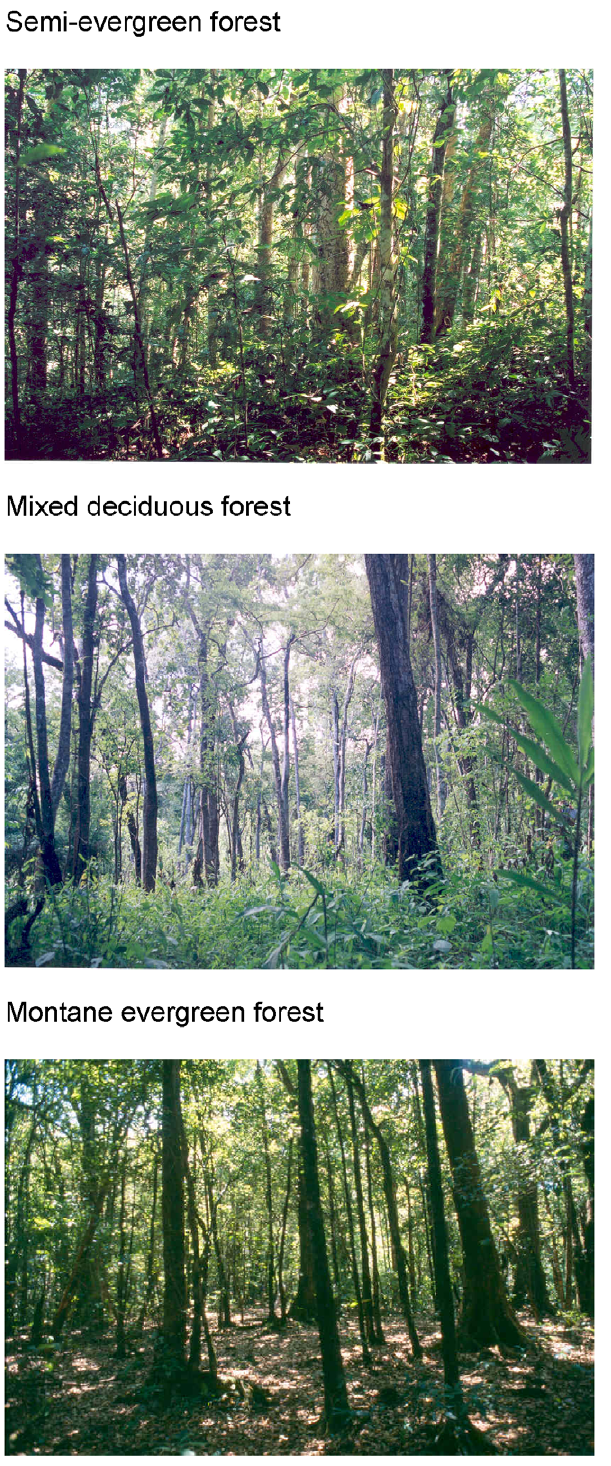
Figure 2. Forest types used by Asiatic black bears and sun bears in Thung Yai Naresuan Wildlife Sanctuary, Thailand, 2001–2003. (A) semi-evergreen forest, (B) mixed deciduous forest, (C) montane evergreen